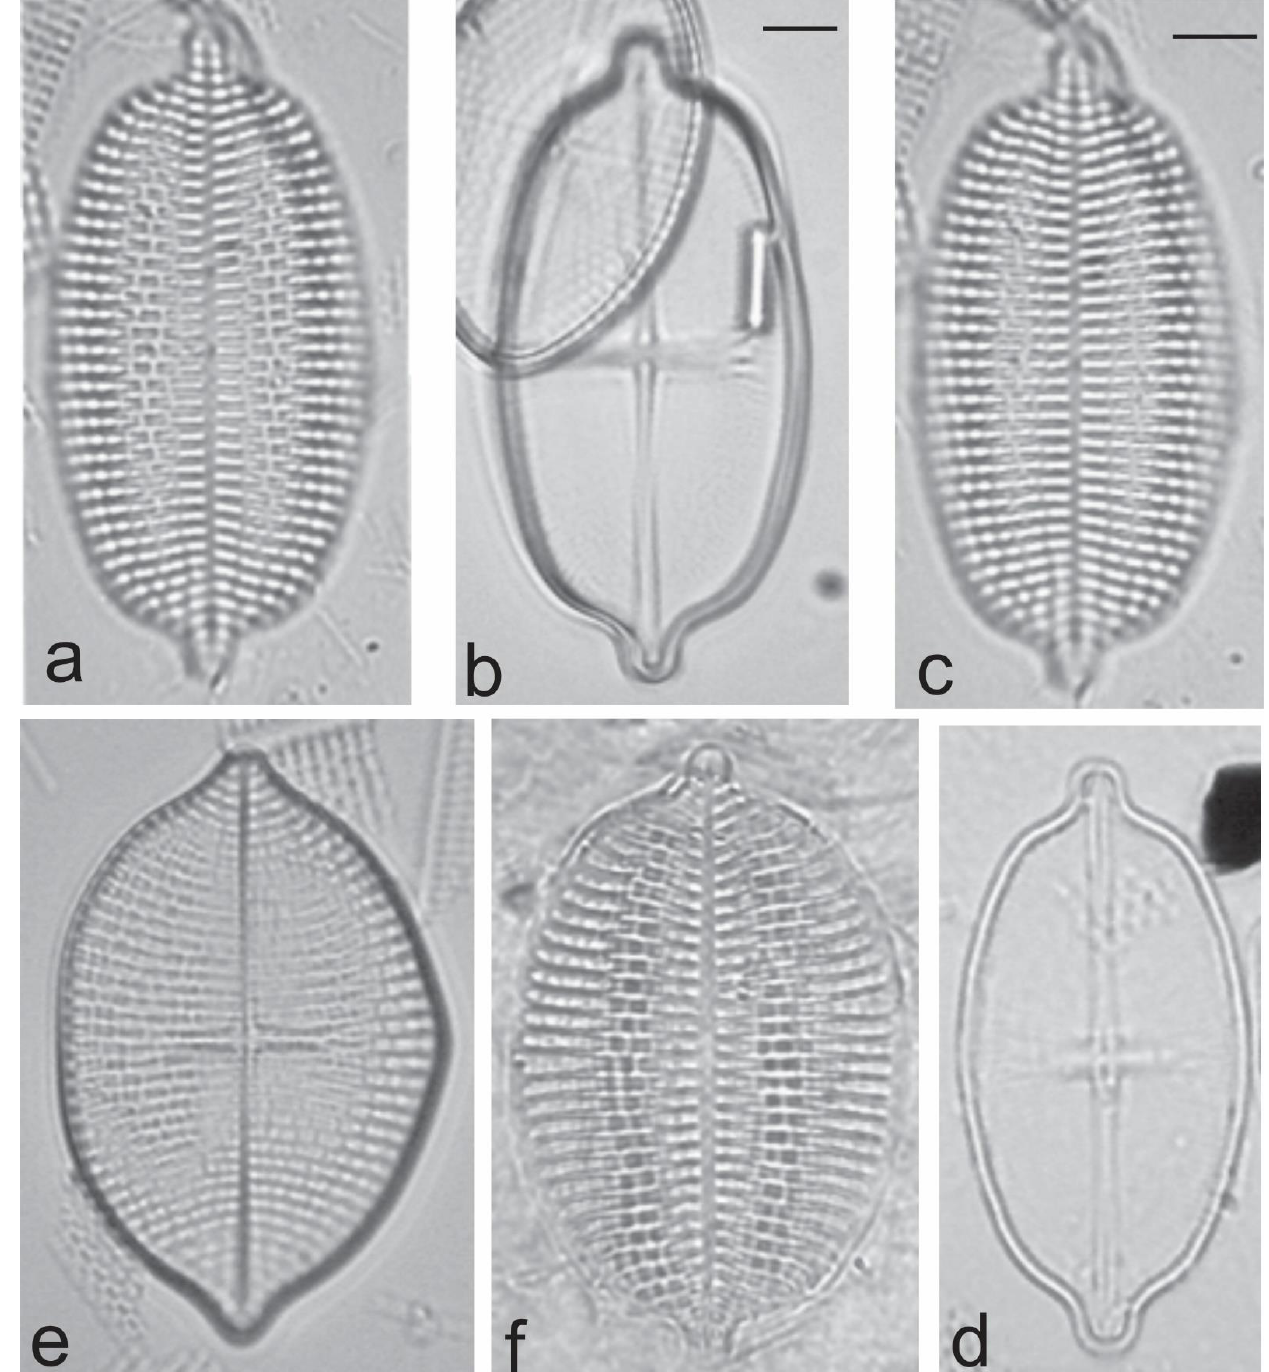
Figure 15. ( a – d ) Achnanthes trachyderma ; ( e , f ) A . apiculata . Scale bar = 5 μm.